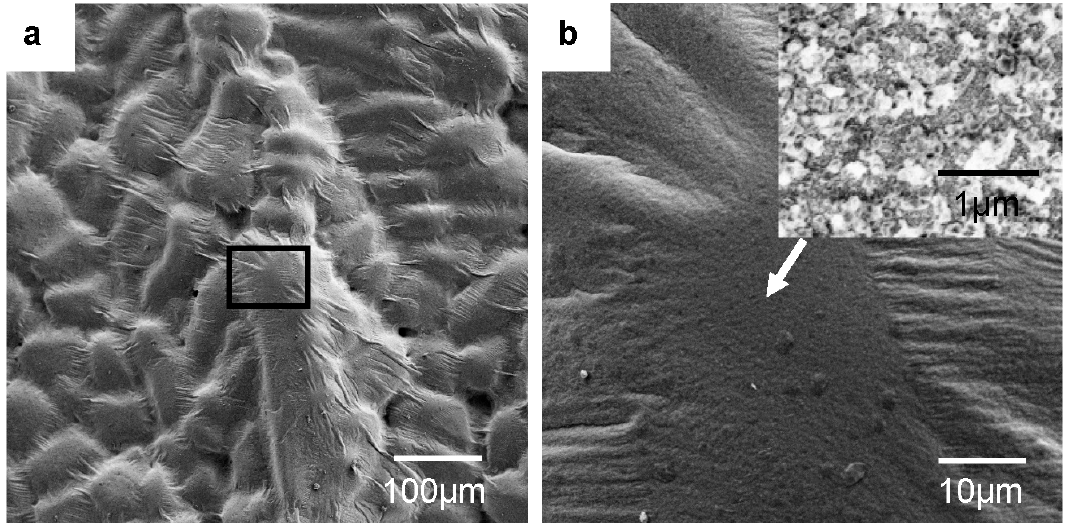
Figure 3. Secondary electron images from region marked 1 (macroscopic non ‐ nodular growth) in Figure 2b, from surface of AZ91D alloy held at 650 °C for 10 s [44] showing ( a ) oxide layer; ( b ) magnification of region outlined by black rectangle in ( a ); detail of predominantly granular MgO nanoparticles (inset).